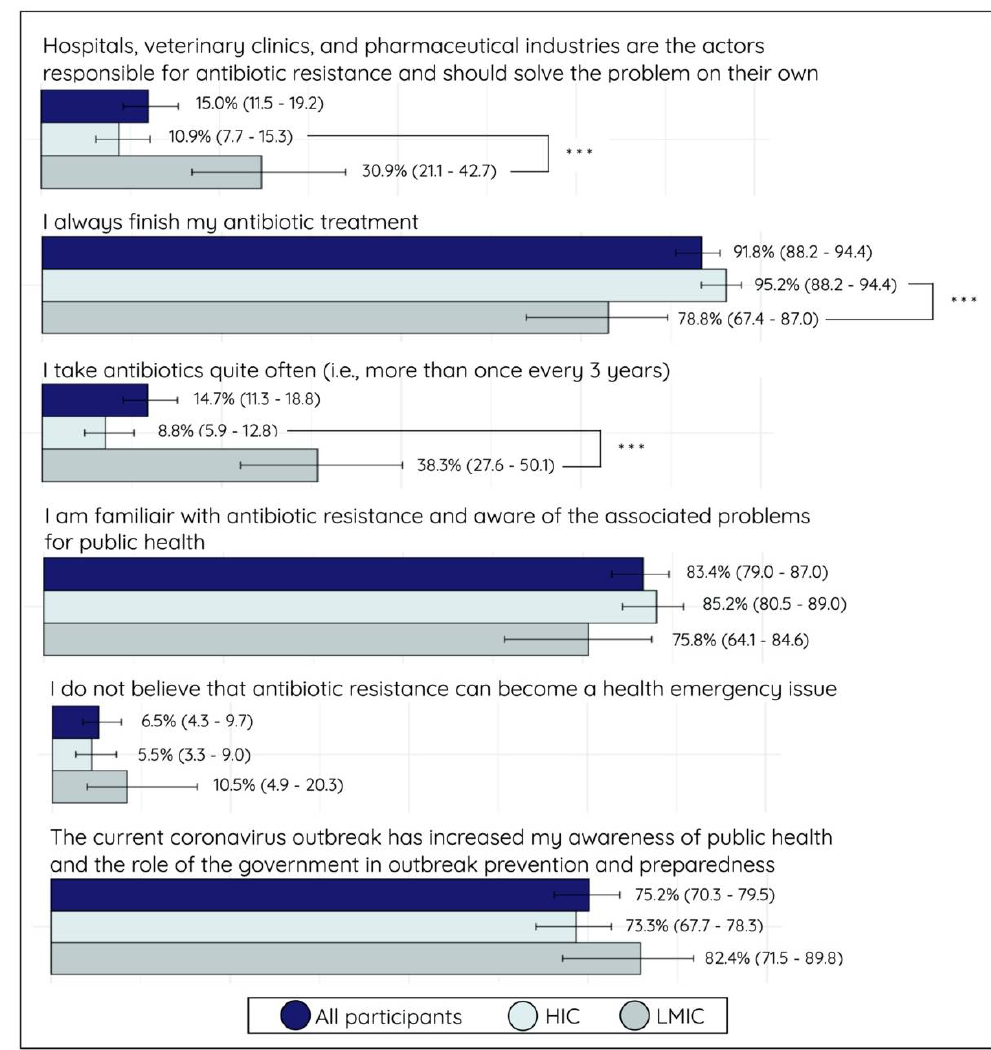
Figure 3. Bar plot (proportion (%) with 95% confidence interval) of personal attitude and perception statements from all participants, stratified for high-income country (HIC) and low- and middle-income country (LMIC) participants. The proportion represents participants who answered the statement with agree or strongly agree. Significance: *** p < 0.001. Of all participants, 41.6% (146/351) and 83.8% (294/351) had a good and fair